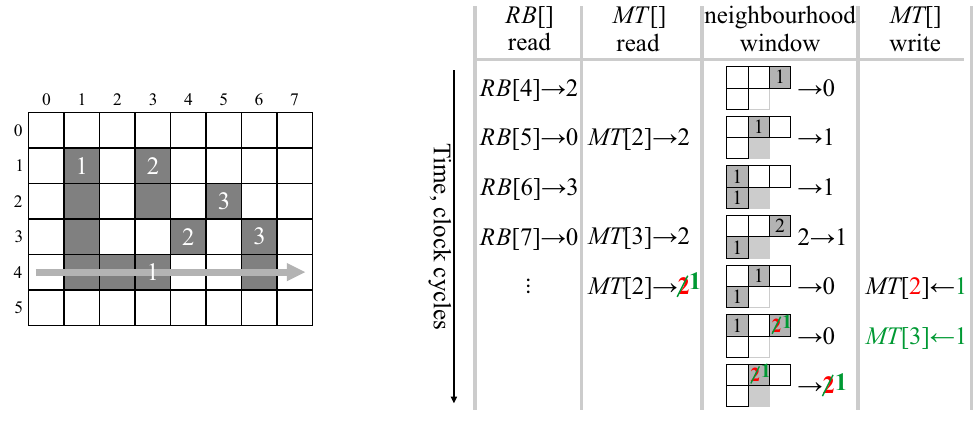
Figure 15. Timing of hazards associated with the merger